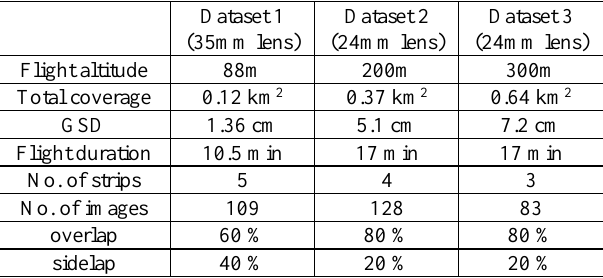
Table 2. Model and main specifications of the